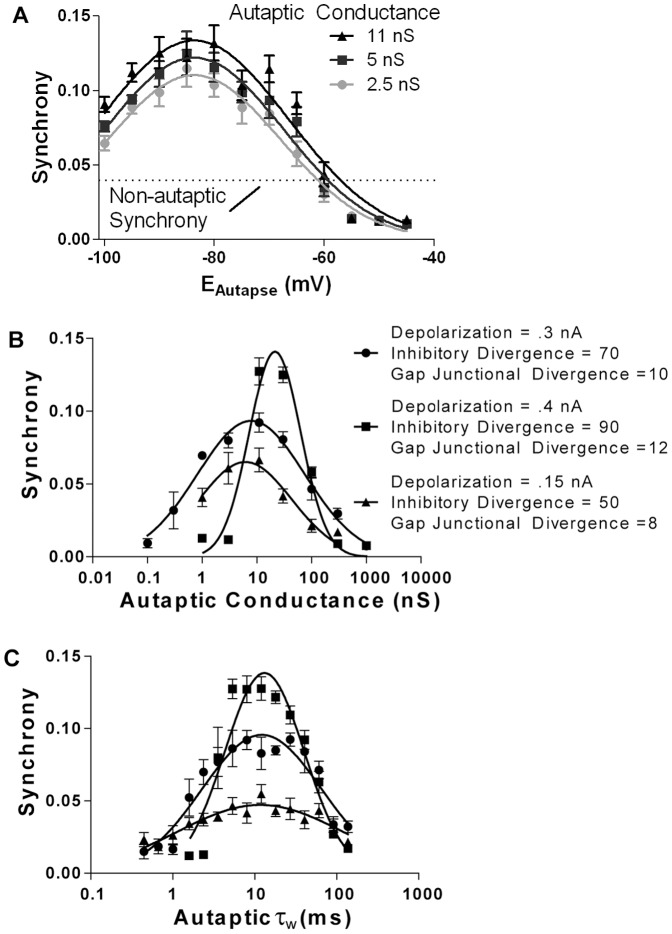
Real autaptic parameters are tuned to those which enhance synchrony.
A. The reversal potential of autaptic currents (but not that of FS→FS synapses) was changed across a simulation with a mean depolarizing current of 150 pA, a gap junctional coupling of 10, and an inhibitory divergence of 70. The reversal potential of autaptic currents need to be between −100 mV and −55 mV to enhance synchrony. B. As the mean autaptic conductance is varied, network synchrony is altered, peaking at values between 6–21 nS (the peaks of the log-normal regression curves). C. As the weighted decay constant of the bi-exponential decay is varied (amplitude ratio constant at 0.6), network synchrony is altered, peaking at values between 11.5–13 ms (the peaks of the log-normal regression curves).